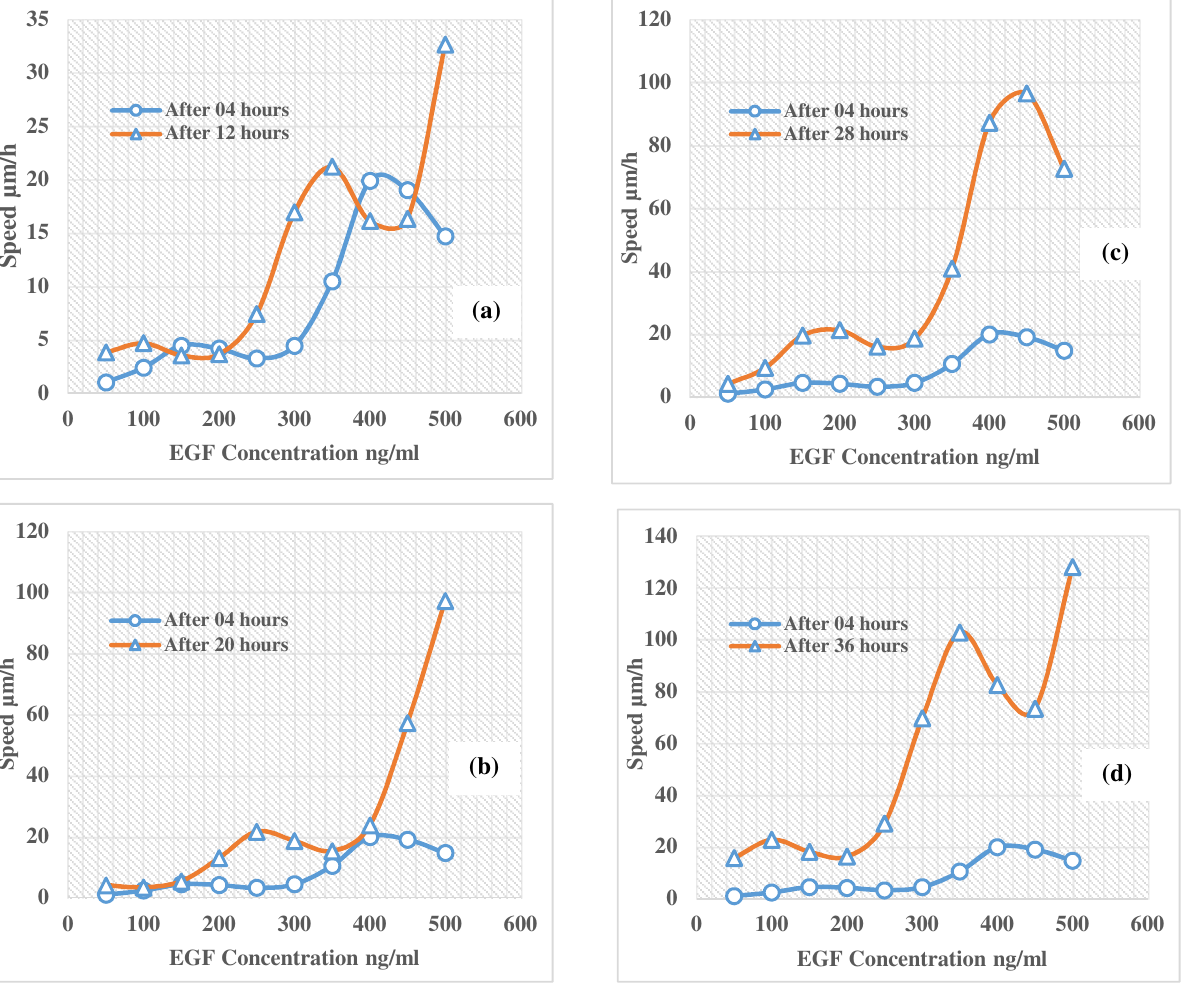
Fig. 9. Speed of healing with respect to the cell concentration of EGF for 4 steps: (a) 12 h, (b) 20h, (c) 28h and (d) 36h compared with 4 hours.